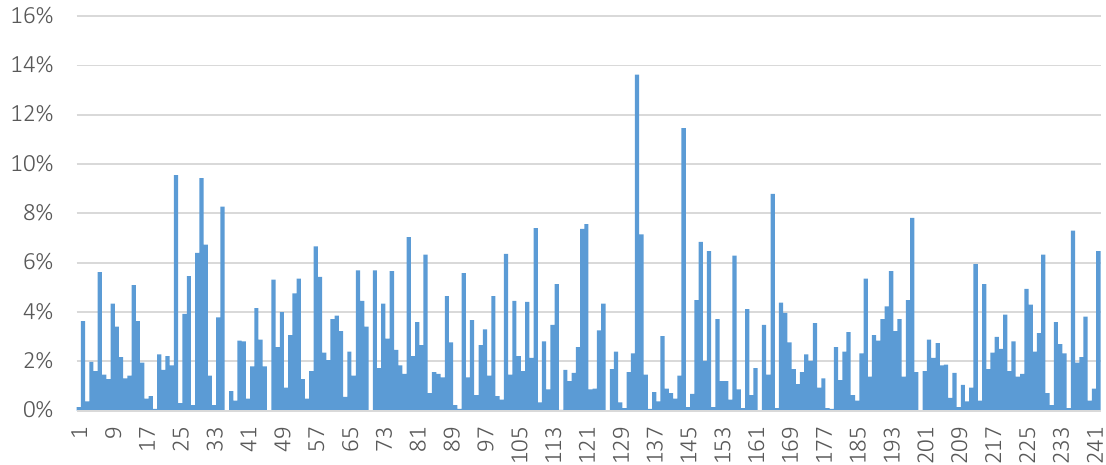
0% Note: Figure 7 depicts the percentage of rejections of each stock, i.e., the number of samples for which the hypothesis of equal variance was rejected by the variance ratio test, over the total number samples for each stock. The x-axis reflects each stock available from January 1, 2000 till December 31, 2014. Figure 7. Percentage of samples in which distributions are not equal using Wilcoxon rank-sum test